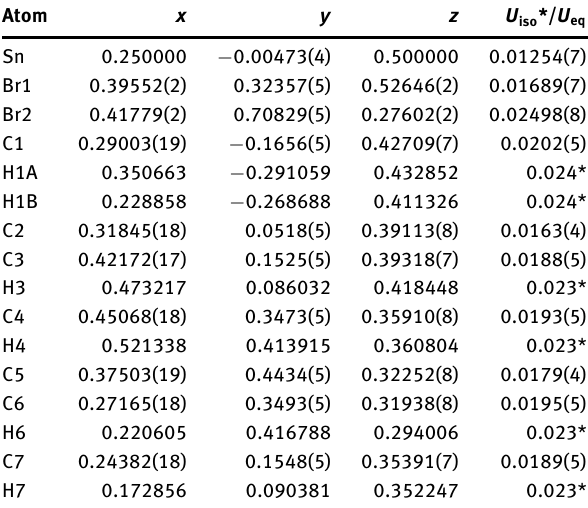
Table 2: Fractional atomic coordinates and isotropic or equivalent isotropic displacement parameters (Å 2